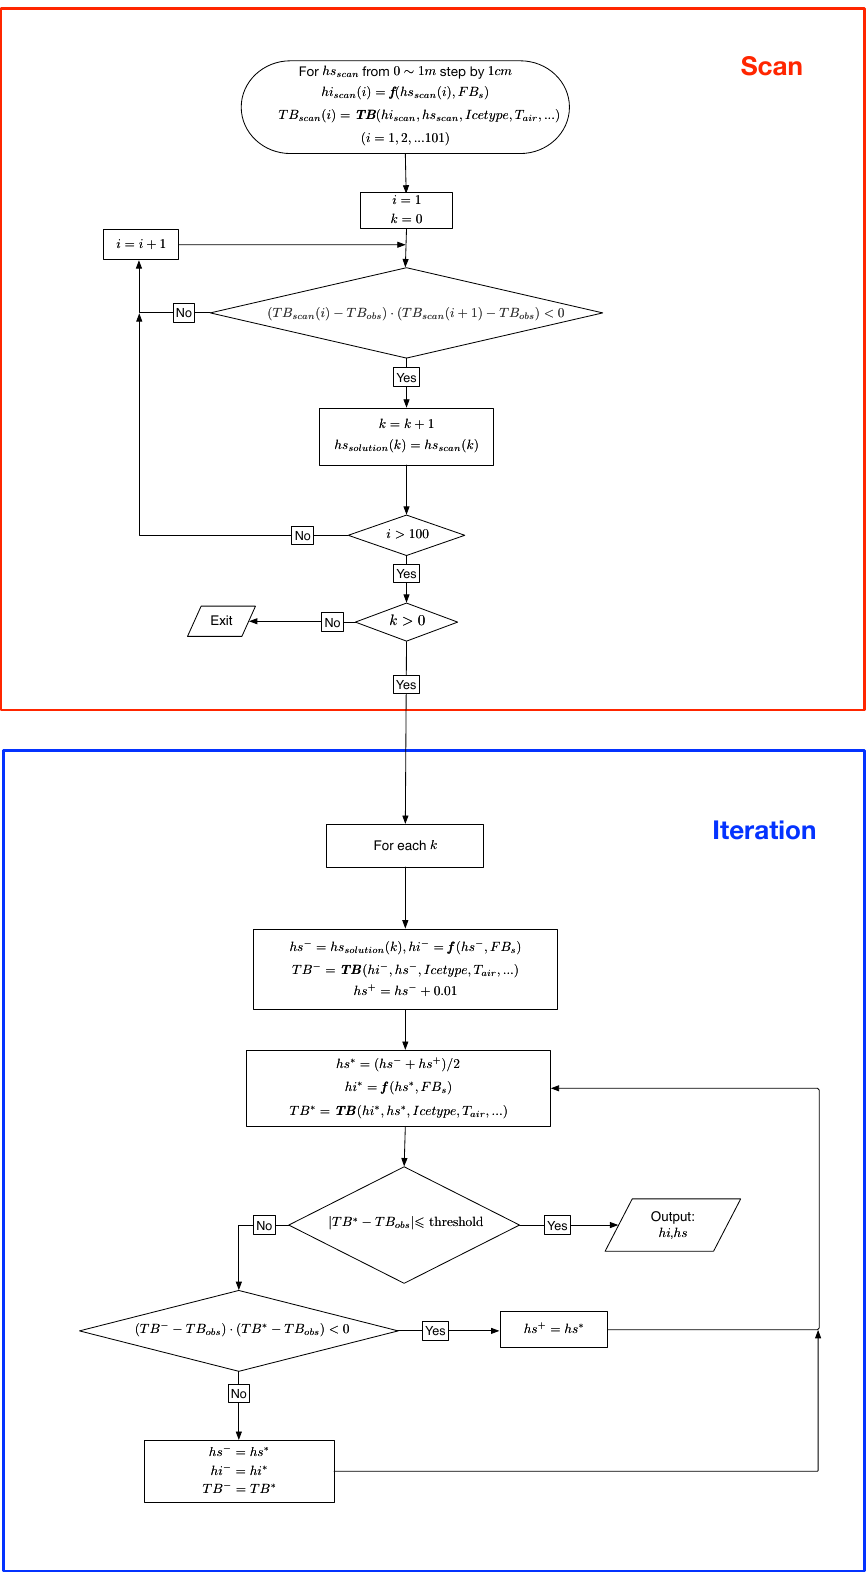
Figure 6. Retrieval algorithm based on data synergy between L-band TB and FB snow